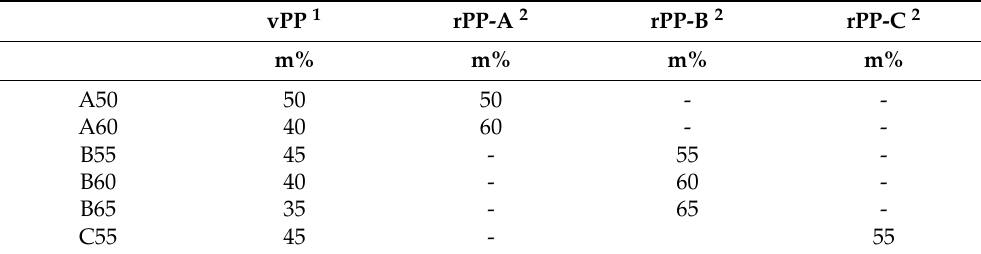
Table 2. List of compounds and their respective amounts of blending partners. To all compounds, additional 0.15 m% Irganox ® 1010 long-term stabilizer [20], and 0.15 m% Irgafos ® 168 processing stabilizer [21] were added during